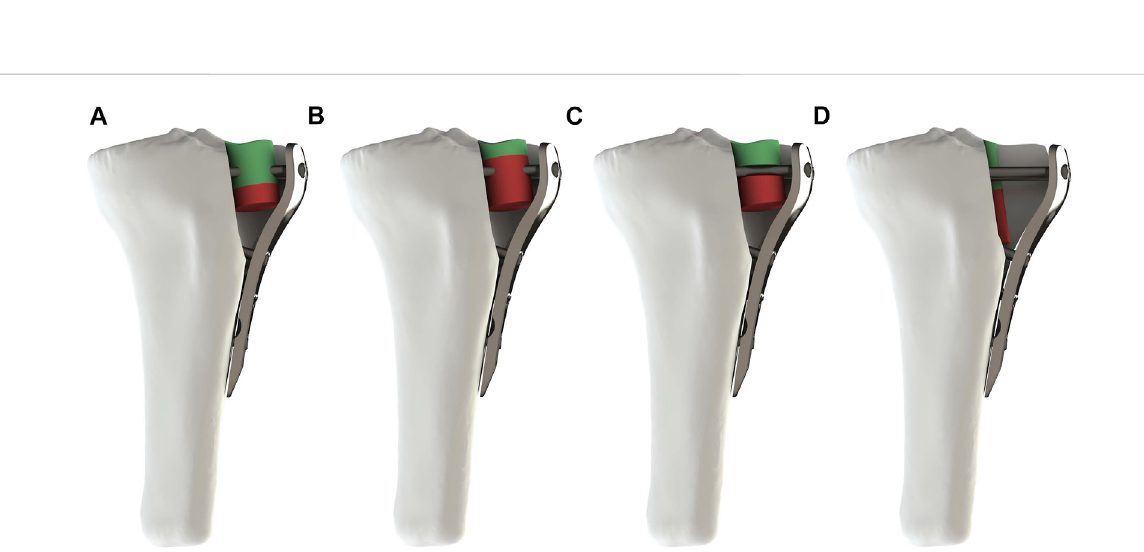
FIGURE 2 Four subtypes of fracture after assembly. (A – D) respectively represented Subtypes. (A) The screw penetrated the depressed fragment. (B) The screw penetrated the fi ller. (C) The screw was located between the depressed fragment and the fi ller. (D) The screw was not in contact with the depressed fragment and the fi